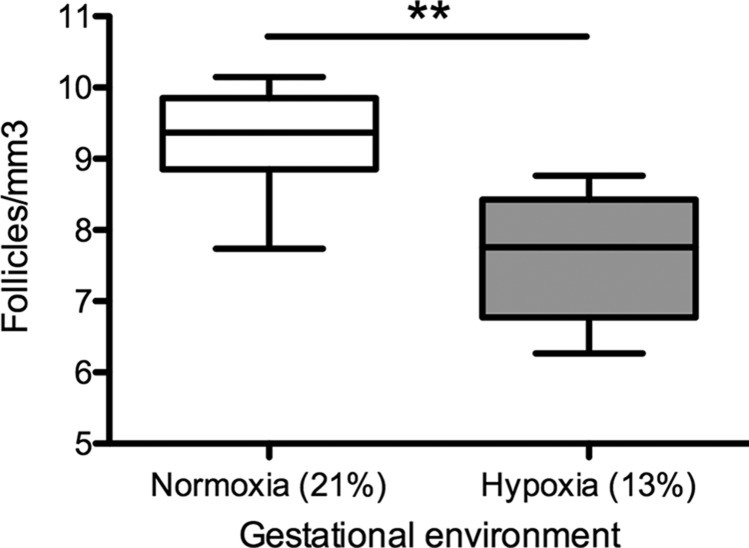
Primordial follicular reserve in adult female rats exposed to gestational hypoxia compared to normoxia. Box plots: median ± upper and lower quartiles; whiskers: maximum and minimum values. Open bars: normoxia (21% oxygen) during gestation; gray bars: hypoxia (13% oxygen) during gestation. Primordial follicle count is shown normalized to cubic millimeters of ovarian tissue. **P < 0.01.